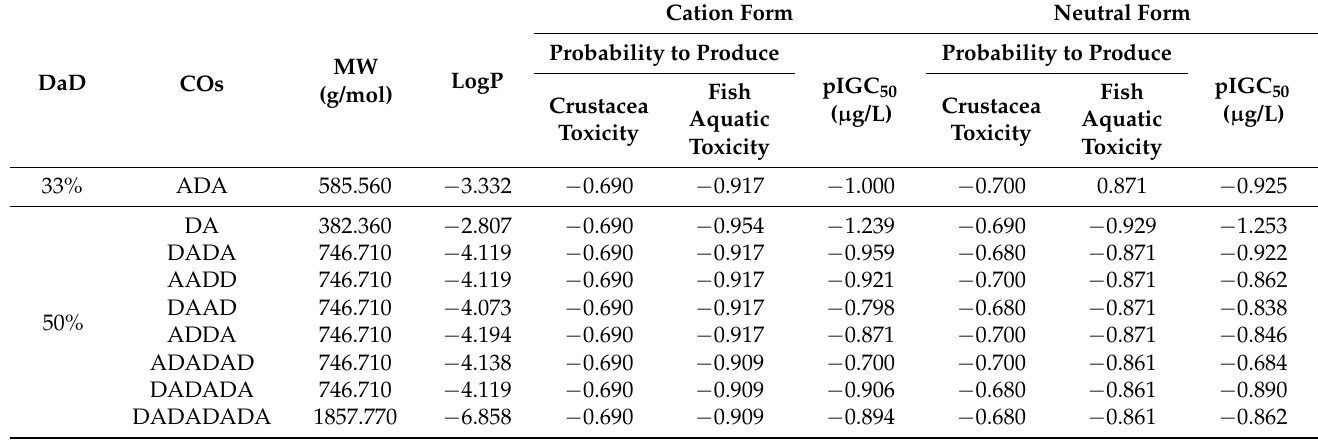
Table 2. Predictions obtained using admetSAR2.0 tool and regarding the physicochemical proper- ties and the effects of partially deacetylated and totally deacetylated chitooligosaccharides (COs) in both neutral and cation forms: MW—molecular weight, logP—partition coefficient, pIGC 50 = − logIGC 50 (IGC 50 is the concentration of a chemical that inhibits 50% of the growth of the